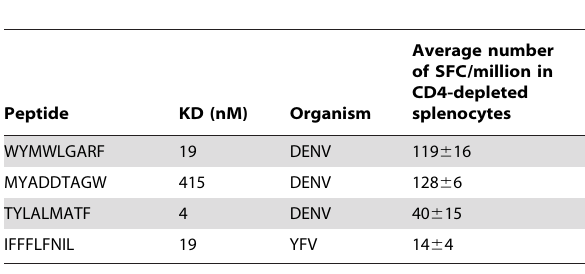
Table 2. ELISPOT results on peptide pool-immunized A*24:02 mice.